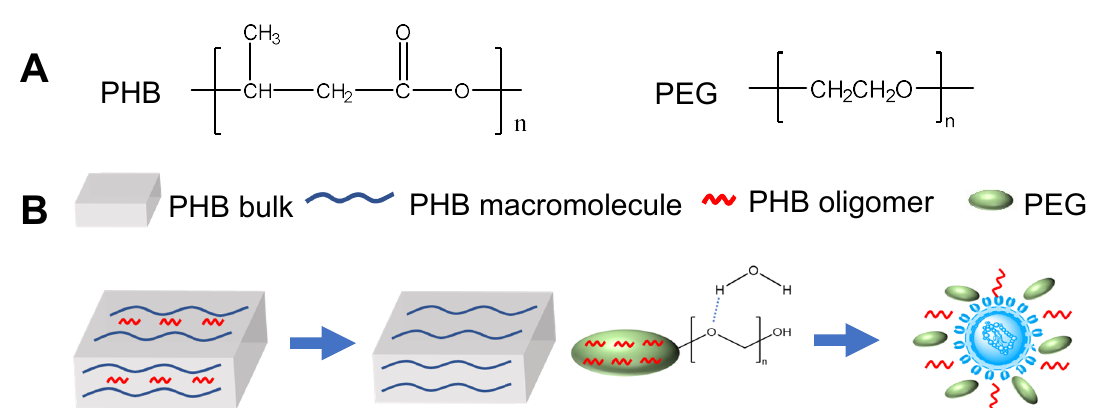
Figure 7. Schematic illustration of hypothesis of dissolution/dispersion of PHB oligomer by PEG. ( A ) Chemical structure of PHB and PEG. ( B ) Two steps are presented as dissolution/dispersion and synergistic antimicrobial effect.